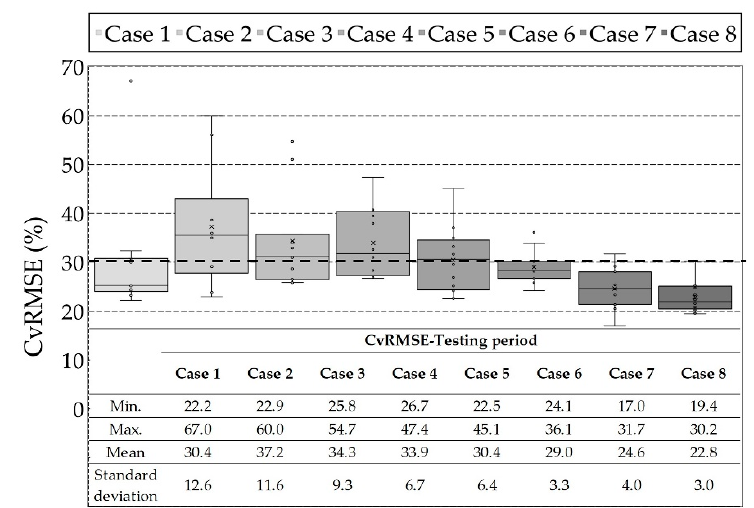
Figure 4. Accuracy according to the number of input variables for the testing period.